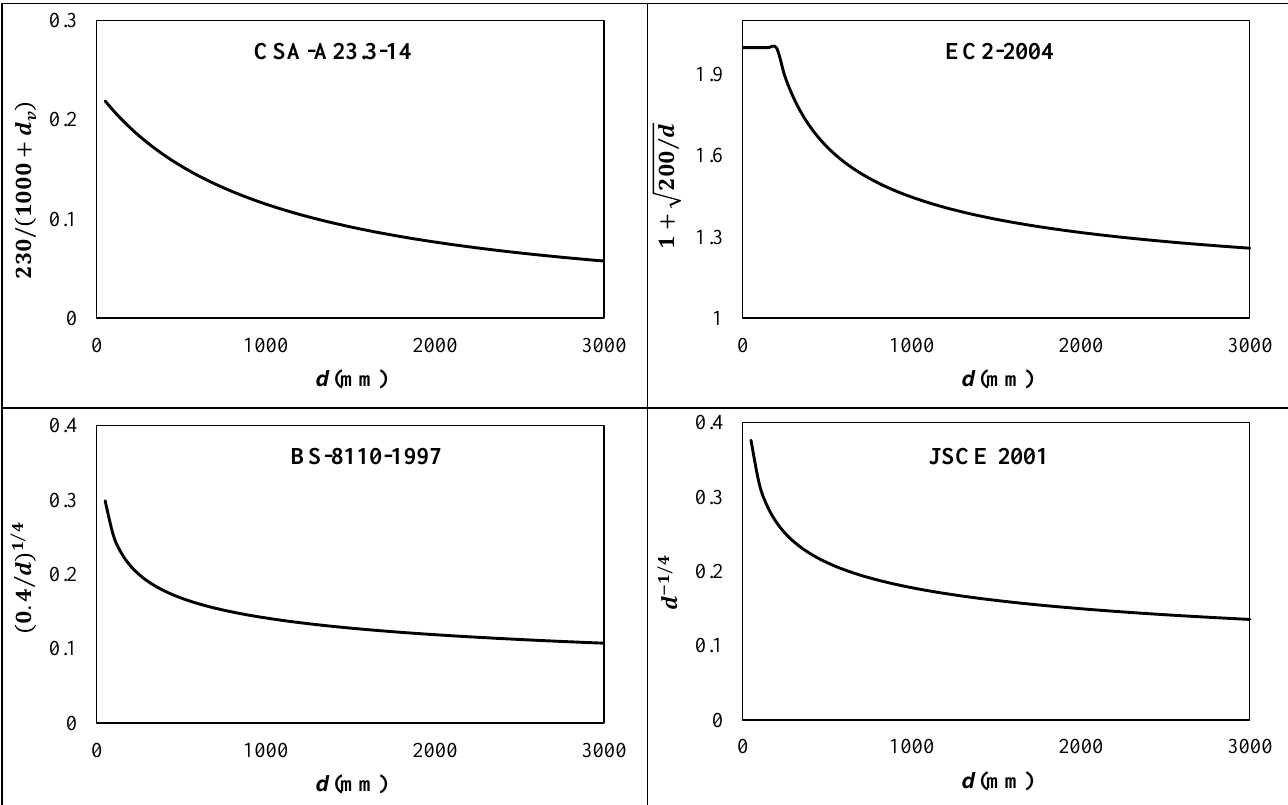
Table 1. Size effect reducing terms from prediction models.